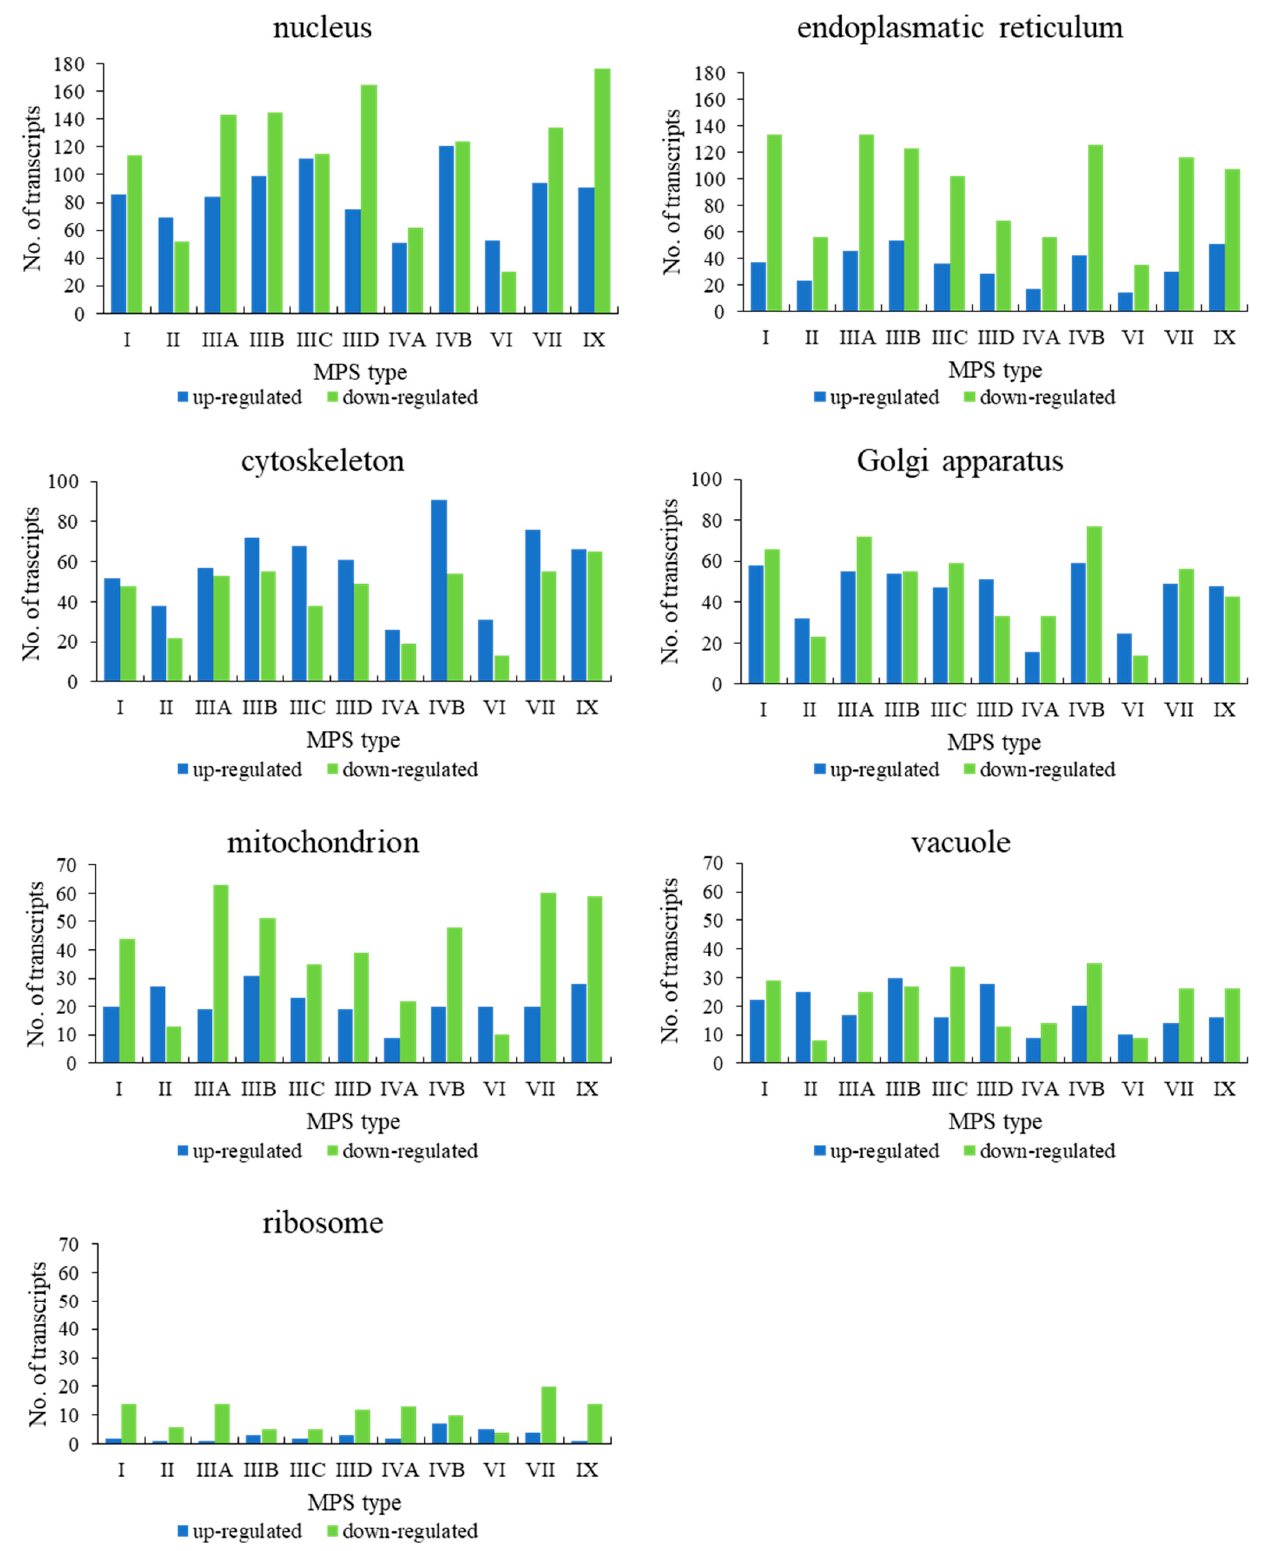
Figure 4. Number of up- and down-regulated transcripts (at FDR < 0.1; p < 0.1) with division into selected organelles (child terms of ‘intracellular membrane-bounded organelle’ (GO:0043231) and ‘intracellular non-membrane-bounded organelle’ (GO:0043232)) in different MPS types relative to control cells (HDFa).